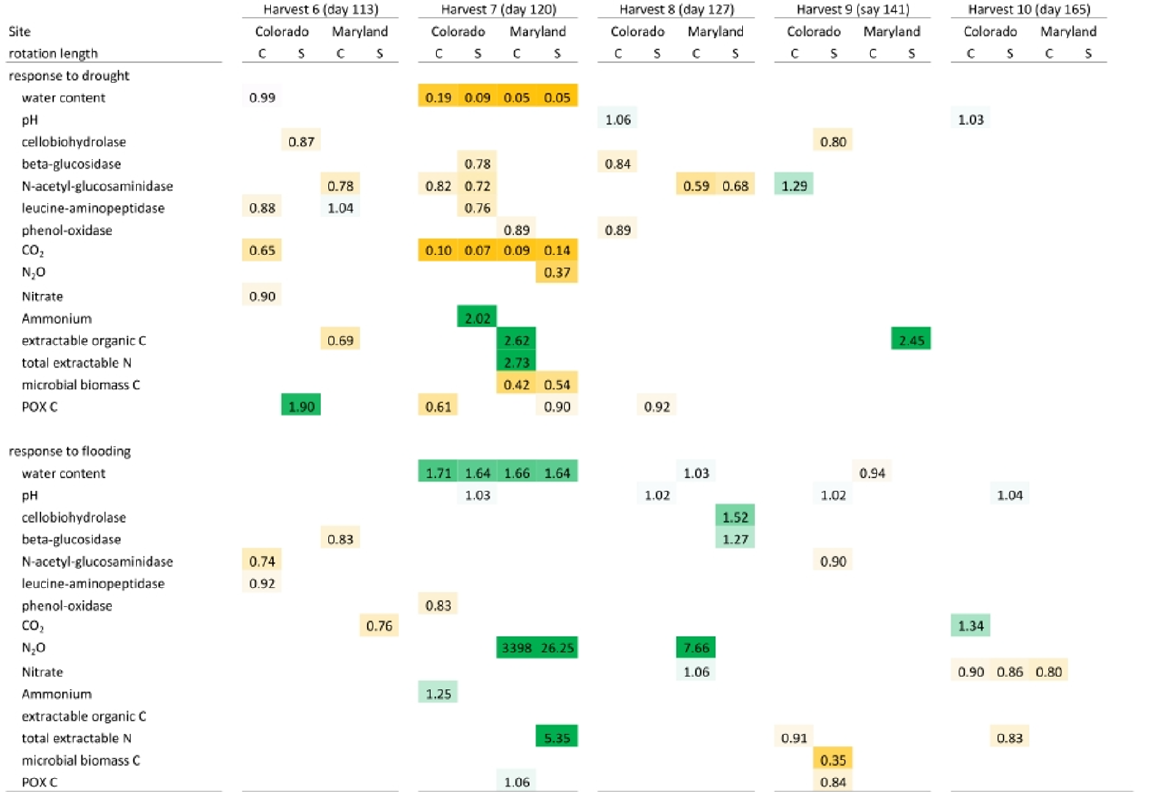
Table 4. Mean response ratios of soil carbon and nitrogen pools, microbial enzyme activities, and CO 2 and N 2 O production in response to drought and flooding before (day 113), during (day 120), immediately after (day 127), 2 weeks (day 141) after, and 6 weeks (day 165) after the fifth stress cycle. Orange colors indicate a reduction relative to the control and green colors represent an increase. Only significant differences ( p < 0 . 05) are shown. Response ratios are calculated as the value for a given treatment divided by the value of the respective control at 50%WHC. C is a complex rotation, S is a simple rotation, and POXC is permanganate oxidizable